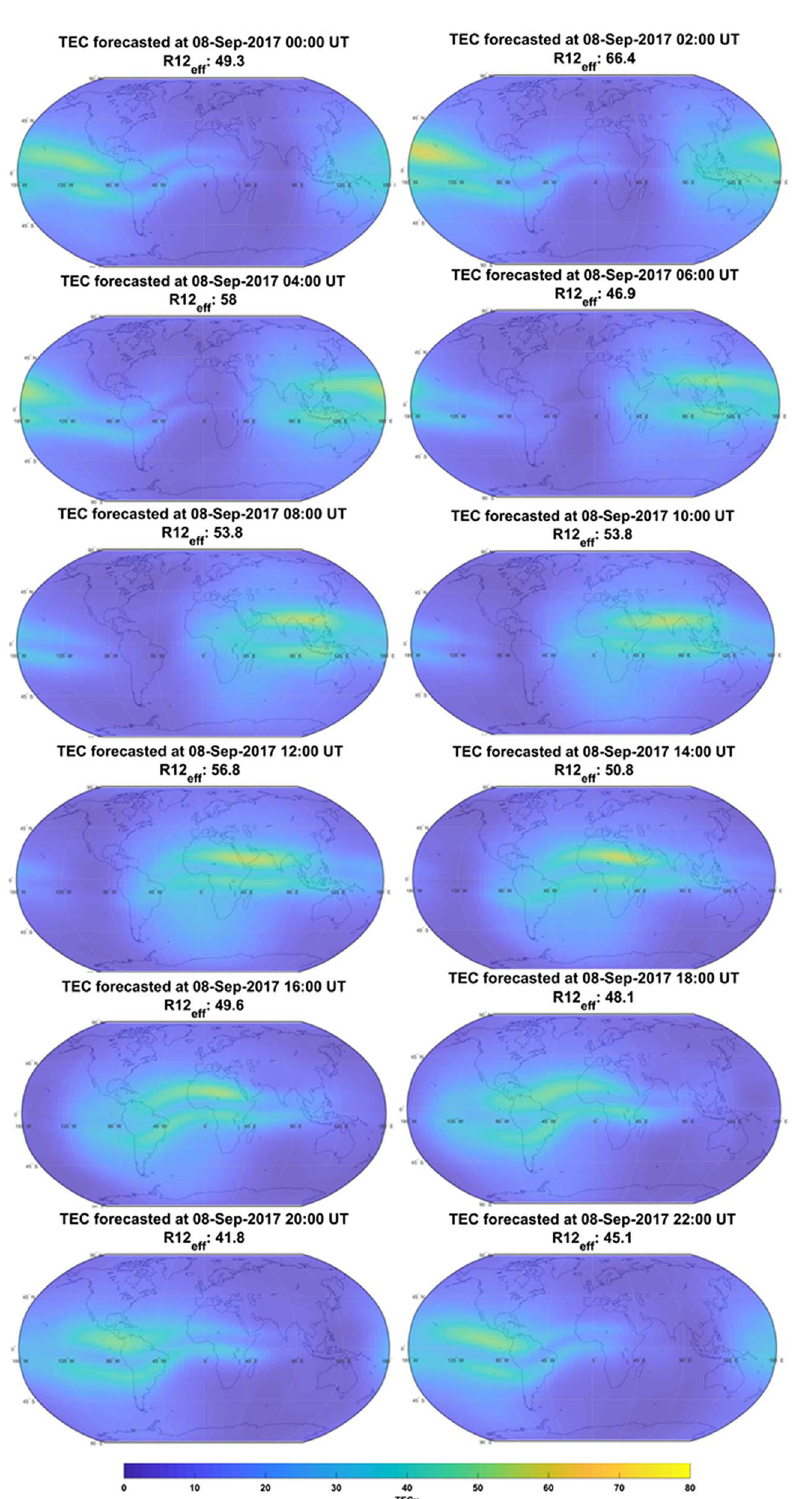
Fig. 7. Example of TEC long term forecasting for the 8 September 2018, from 00:00 UT to 22:00 UT. The forecasting time and the corresponding value of R12eff is reported on top of each